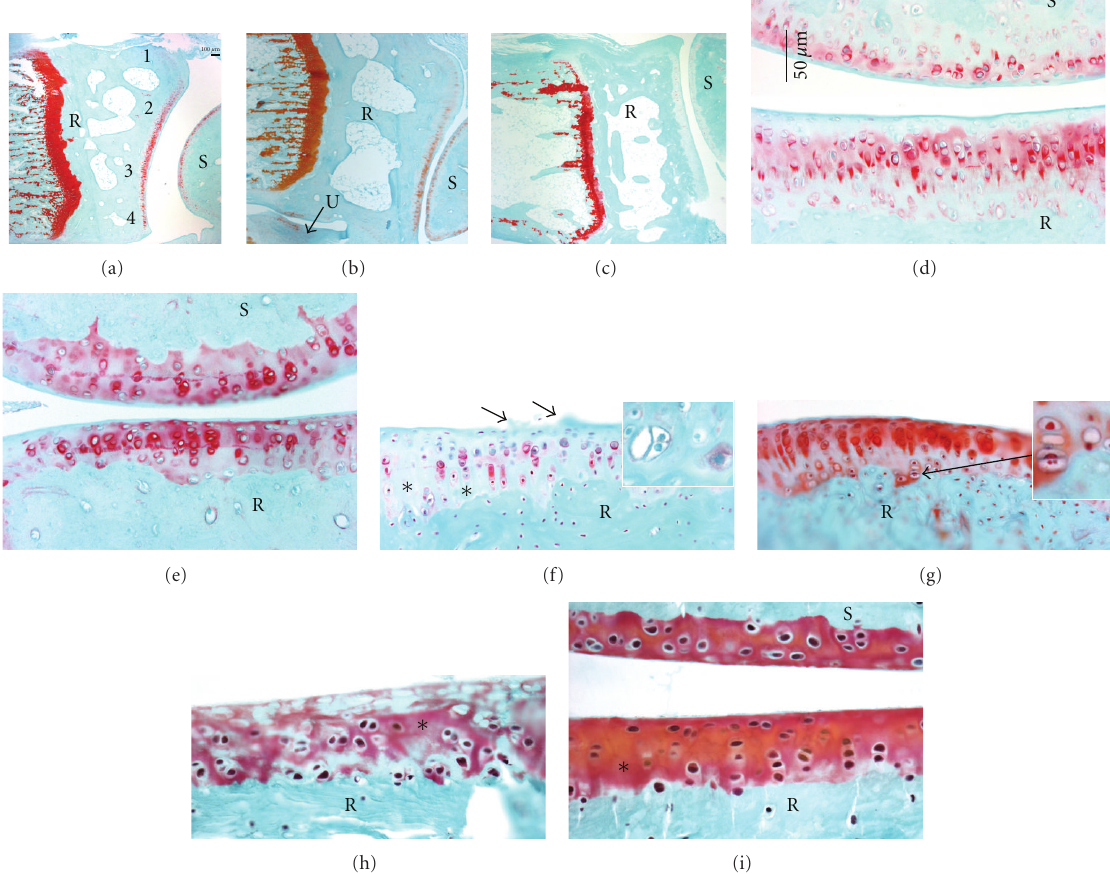
Figure 3: Distal radii and carpal bones stained with safranin O and fast green. (a)–(g) are longitudinal sections of para ffi n embedded radius, ulna and carpal bones. (a)–(c) Low-power micrographs showing distal radius, scaphoid bones and articular cartilage in (a) NC (normal control), (b) TR (trained control), and (c) HRHF rat (performed the high-repetition high-force task for 12 weeks). (a) also indicates the 4 zones of the articular cartilage assessed in the radius. (d)–(g) Higher-power images showing the distal radii articular cartilage of (d) untreated TR, (e) TR + IBU (trained controls receiving ibuprofen treatment in final 8 weeks), (f) HRHF, and (g) HRHF + IBU rats. (f) demonstrates an HRHF animal with structural changes (surface pannus, arrows), cellular changes (hypocellularity in areas indicated with ∗ ), and dramatically reduced proteoglycan staining in the articular cartilage (red-pink safranin O staining). The inset in (f) is a higher-power micrograph from another HRHF rat showing chondrocytes that appear to be proliferating. The inset in (g) shows a higher-power micrograph from area indicated with arrow that also contains proliferating chondrocytes. (h)-(i) Loss of safranin O staining in HRHF articular cartilage was verified in plastic embedded bones that were also cut longitudinally. Radii and scaphoid articular cartilages of (h) HRHF and (i) HRHF + IBU are shown. Scale bars = 50 μ m. B: bone, S: scaphoid